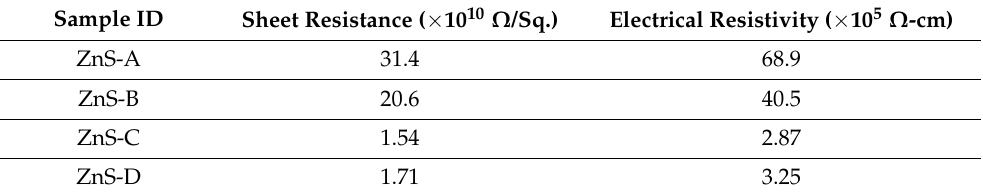
Figure 8. Voltage and current plot of ZnS-A, ZnS-B, ZnS-C, and ZnS-D thin films.